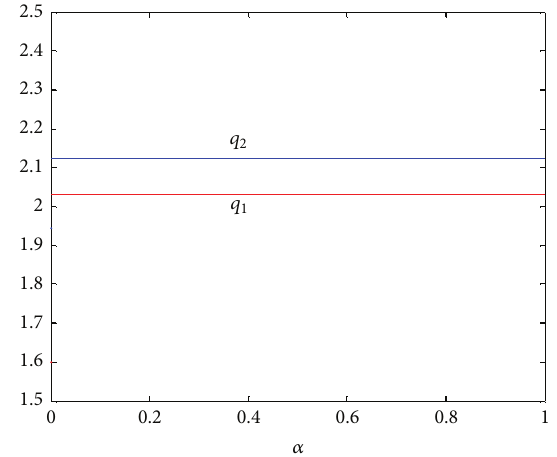
Figure 10: The stable status of the system as a function of time 𝑡 with the controlling factor 𝑘 = 0.8 and the parameter 𝛼 = 0.46 .